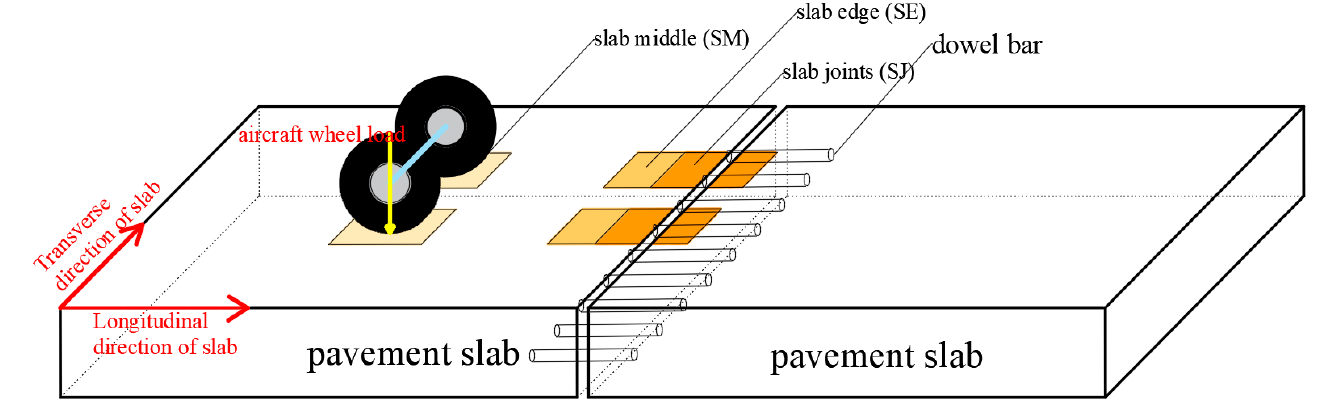
Figure 5. Diagram of an aircraft’s wheel load acting on different positions of the pavement